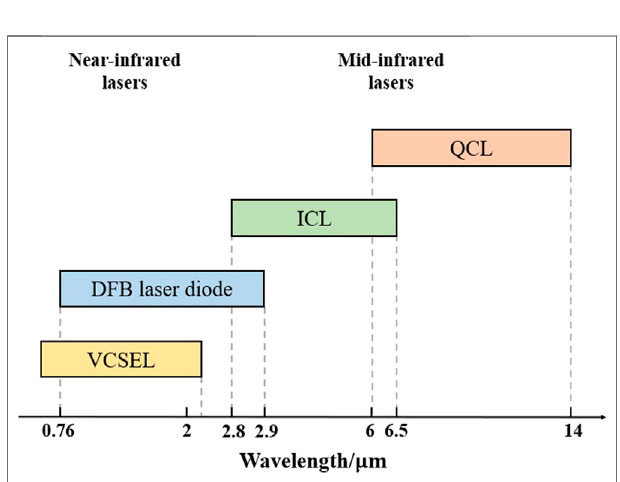
FIGURE 3 | The characters of VCSEL, DFB laser diode, ICL, and QCL, according to the data from Nanoplus.